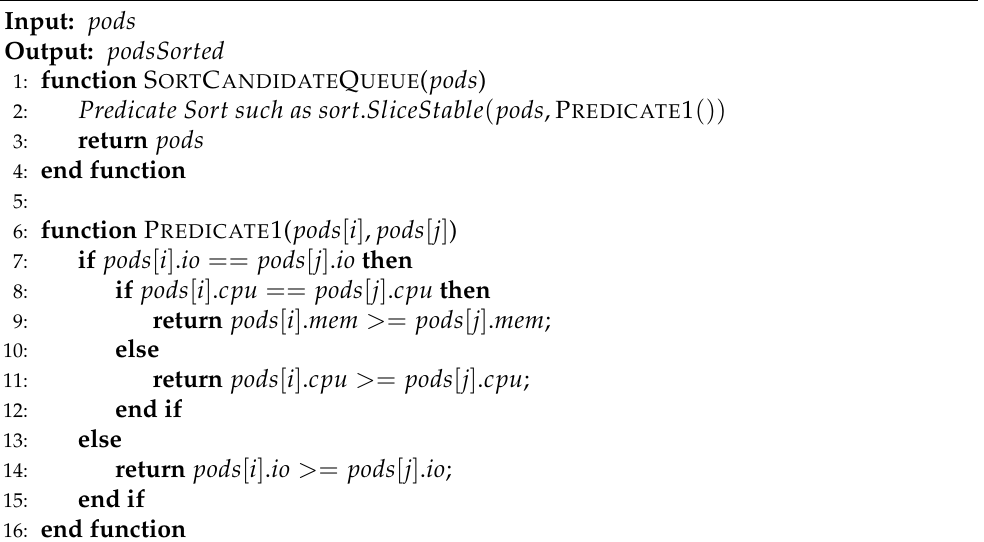
Algorithm 1 Sorting in Candidate Queue